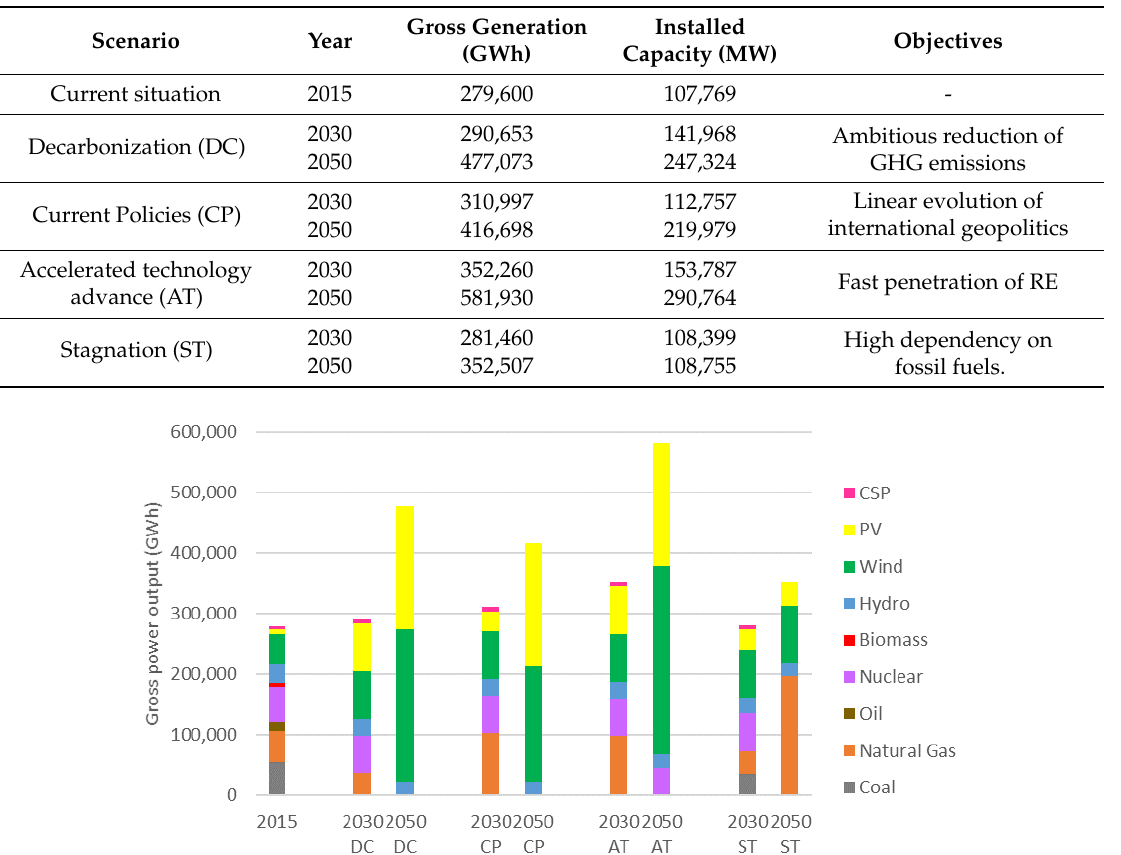
Figure 4. Projections of electricity generation and technology mix in Spain (2030–2050) compared to reference year 2015.